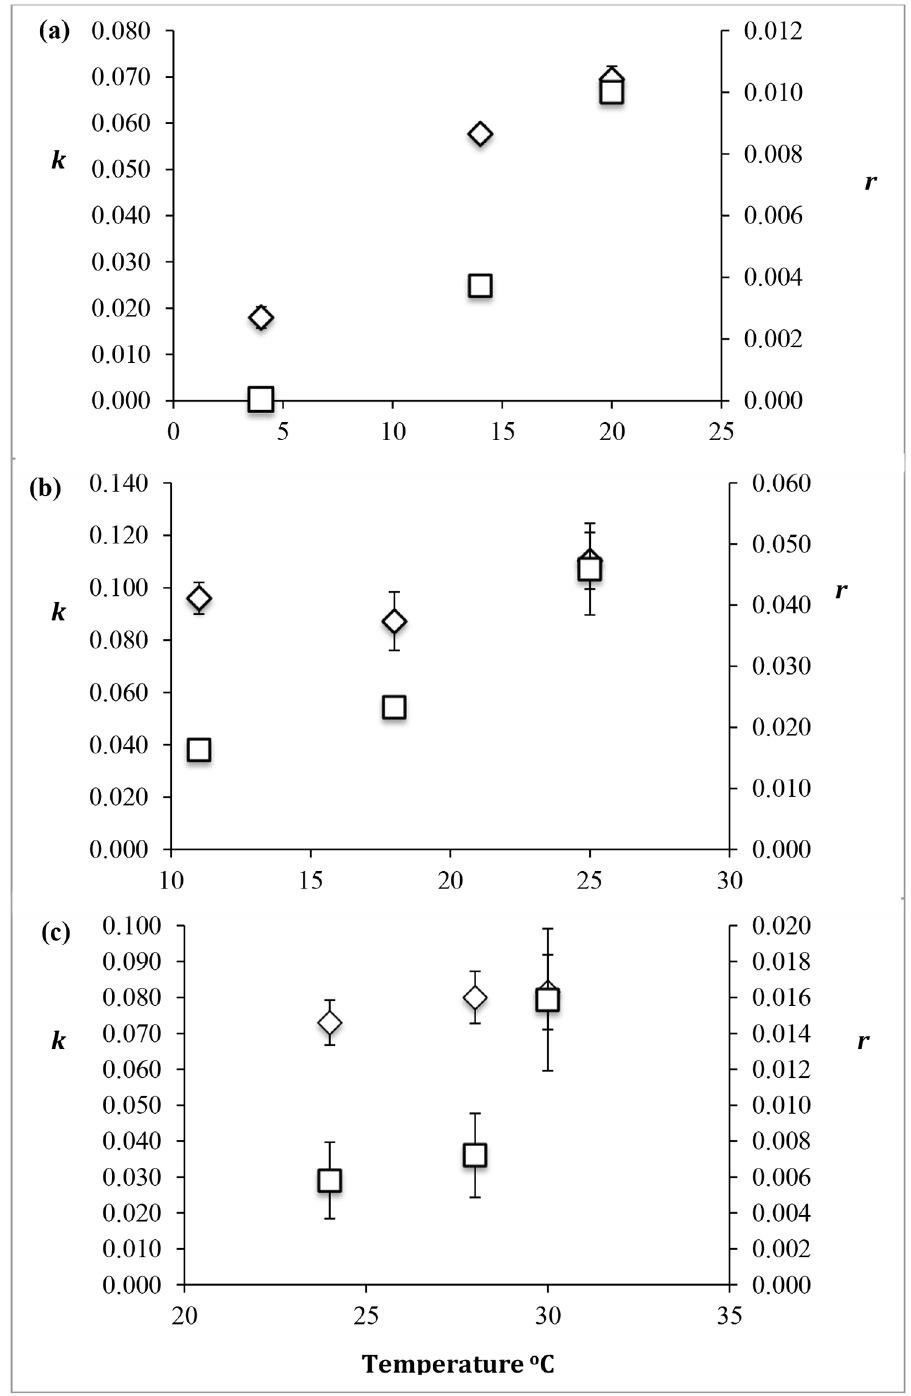
Fig 5. Damage ( k , diamonds) and repair ( r , squares) of (a) polar, (b) temperate and (c) tropical Chlorella strains as a function of temperature. Units for k and r are min -1 . Vertical bars denote standard deviations from triplicate